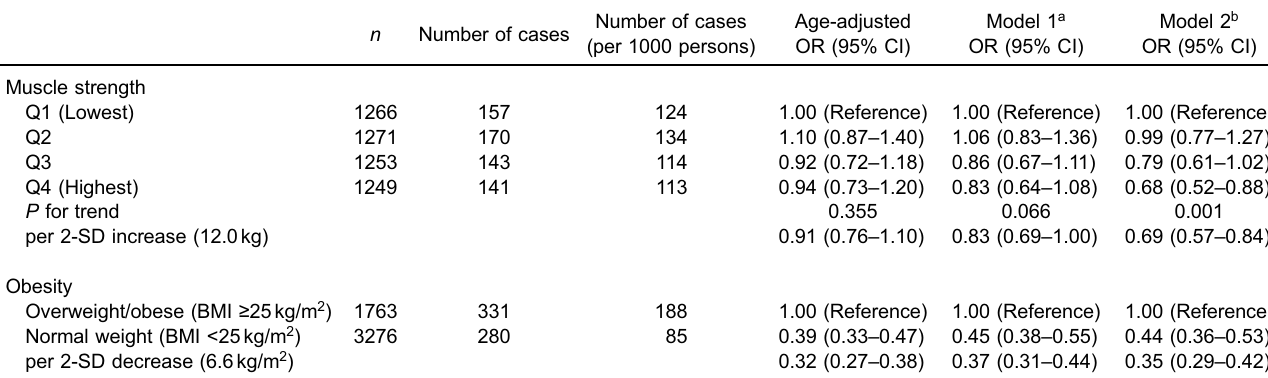
Table 4. Odds ratios for prevalence of type 2 diabetes according to muscle strength categories and obesity status